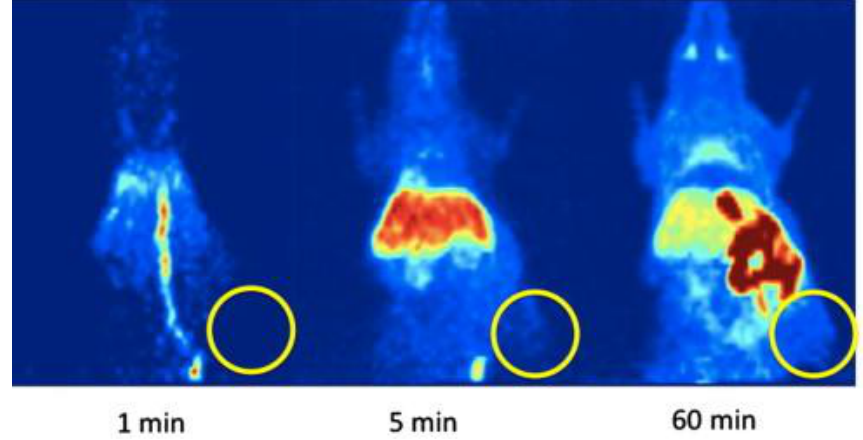
Figure 5. Representative PET images of a HT-29-tumor-bearing mouse (maximum intensity projec- tions) at 1, 5, and 60 min after a single intravenous injection of [ 18 F] 27 (circle: position of the subcu- taneously xenotransplanted tumor). Figure readapted with permission from publisher [74].